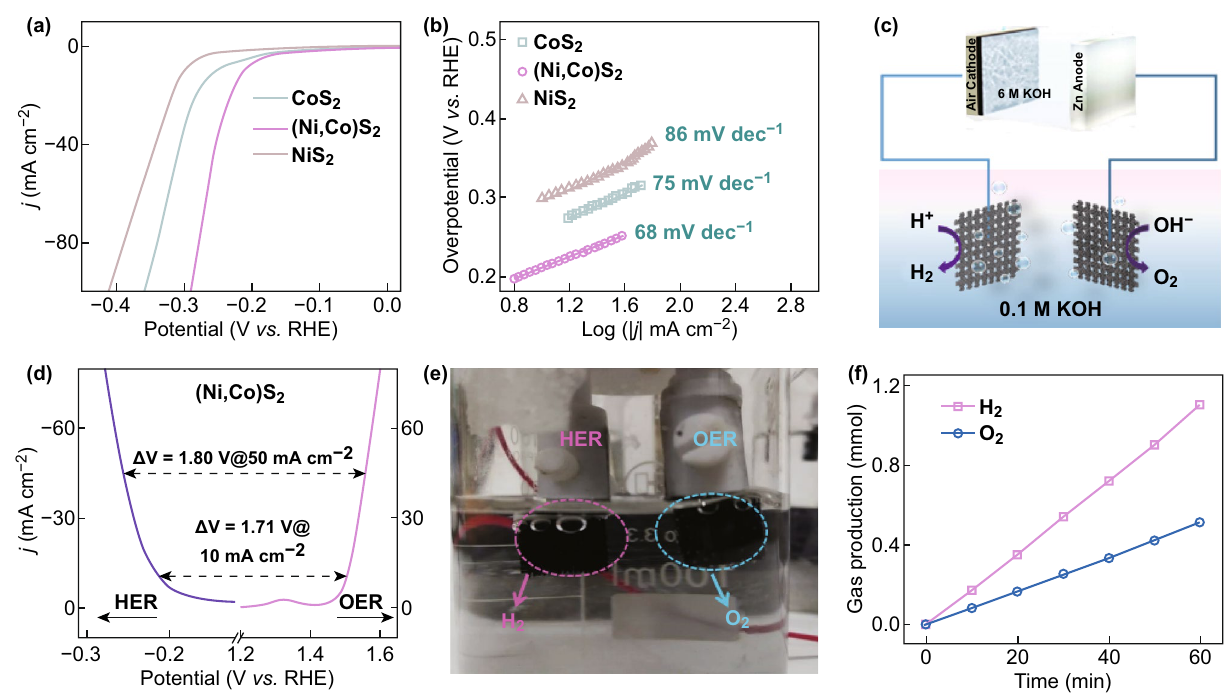
Fig. 6 a HER polarization curves of (Ni,Co)S 2 , NiS 2 , and CoS 2 at 5 mV s −1 in 0.1 M KOH. b Tafel slopes obtained from their polarization curves. c Schematic diagram of the self-assembled water-splitting system. d LSV curves of overall water splitting by (Ni,Co)S 2 electrocatalyst in a two-electrode configuration at a scan rate of 5 mV s −1 . e Two electrodes after water splitting powered by two in-series (Ni,Co)S 2 -based Zn–air batteries. f Time dependence of the mole quantities of H 2 and O 2 produced in the self-driven overall water-splitting